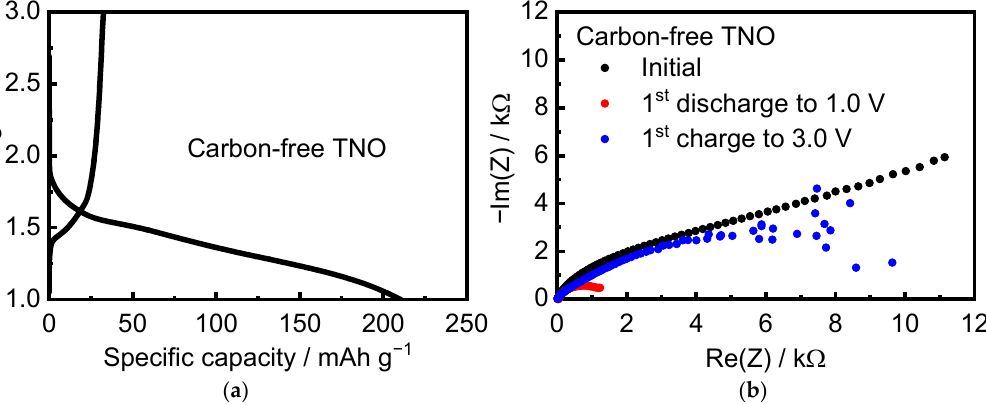
Figure 9. ( a ) Cycling profiles and ( b ) in situ EIS spectra of carbon-free TNO mixed with the binder.